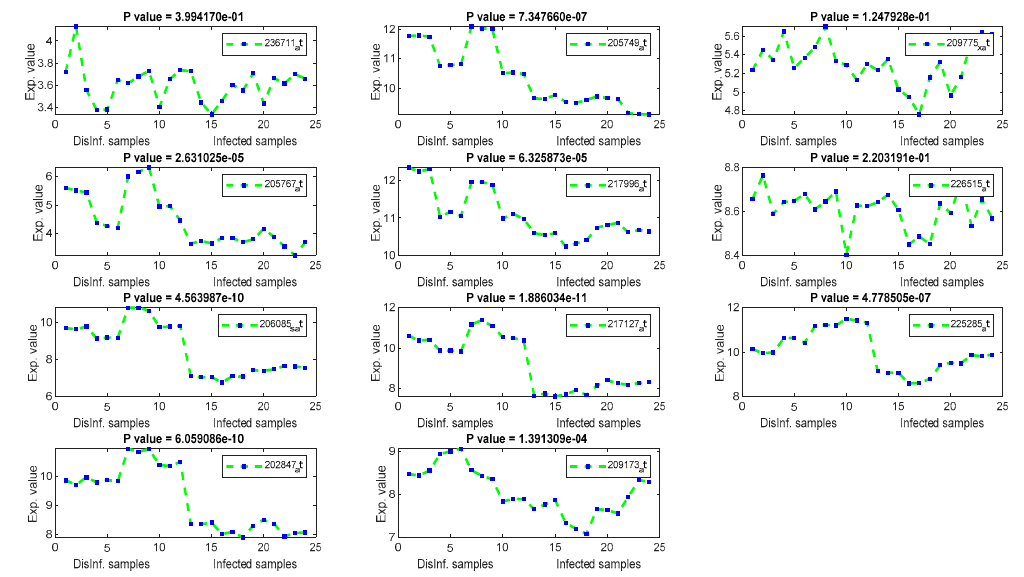
Algorithms 2019 , 12 , x FOR PEER REVIEW Figure 6. The gene signal profiles of top ranked key genes retrieved using Euclidean distance.